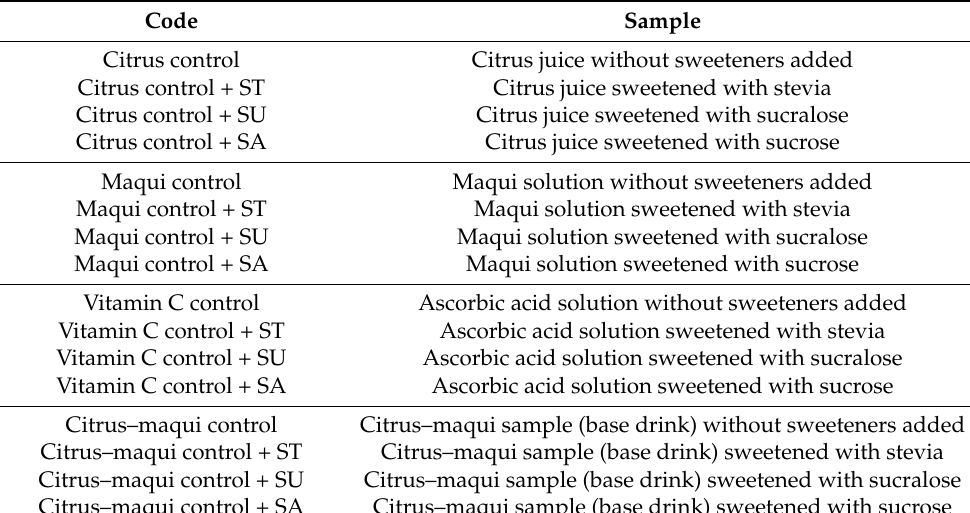
Table 1. Codification of samples included in the experimental